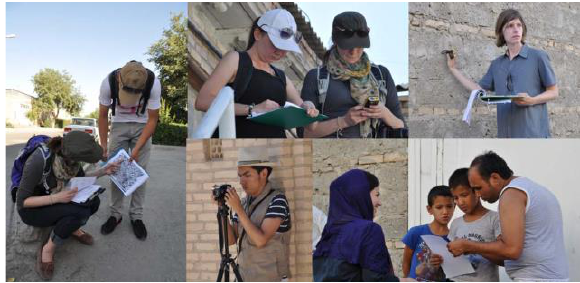
Figure 7. Surveyors during field work in Bukhara. © UNESCO Field survey project